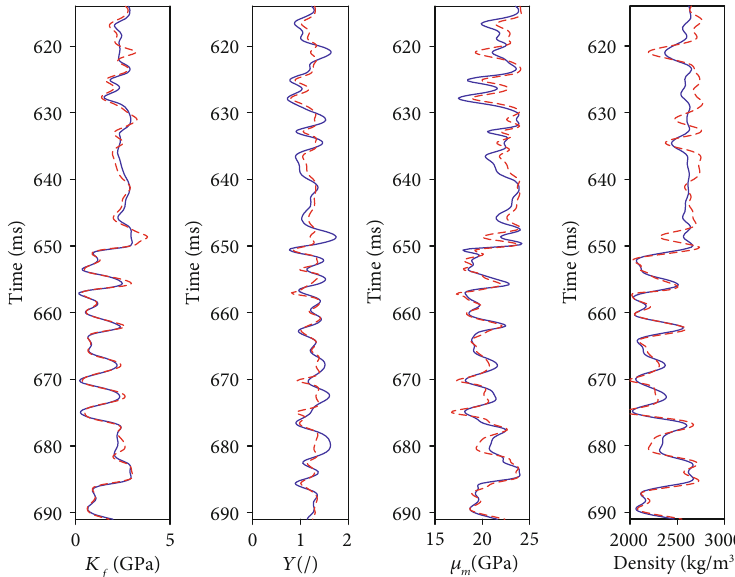
Y , μ f , m , and density (dashed line) from the noisy synthetic angle gather with